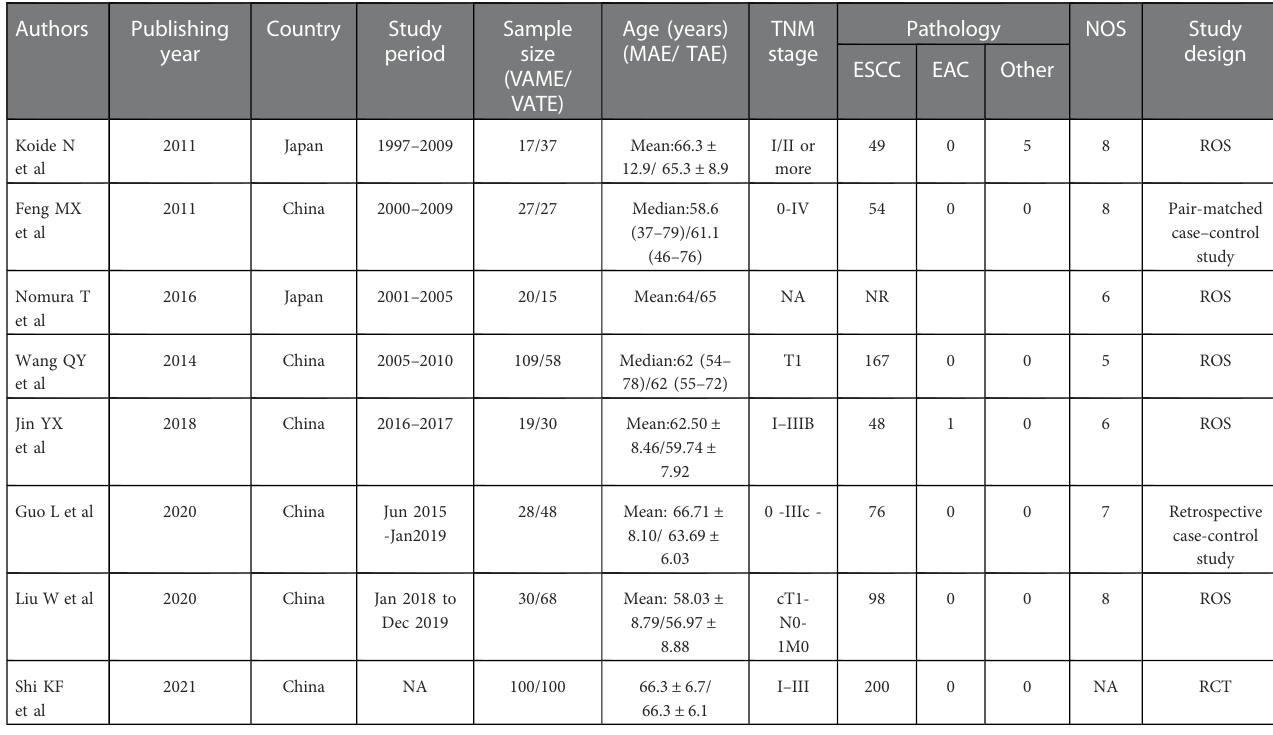
immediately excluded by screening the titles and abstracts. We read